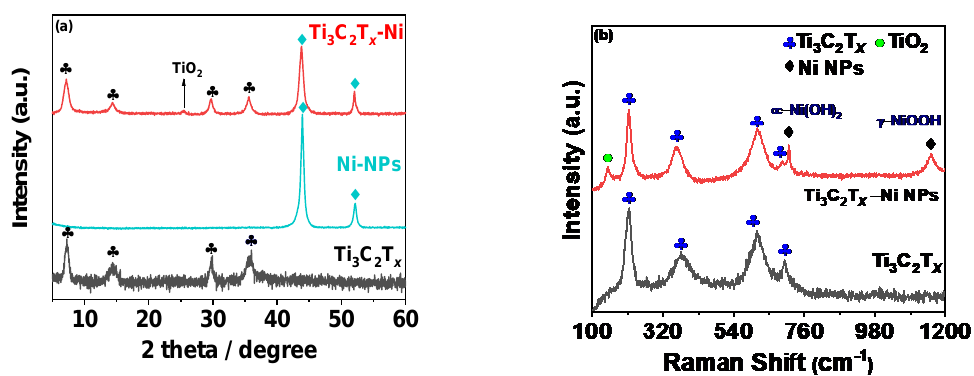
Figure 2. ( a ) XRD pattern recorded for MX − Ni composites in reference to pristine Ti 3 C 2 T x , and Ni NPs; ( b ) corresponding Raman spectrum with typical Ti 3 C 2 T x , Ni NPs bands with evidence of Ti 3 C 2 T x derived TiO 2 particles.